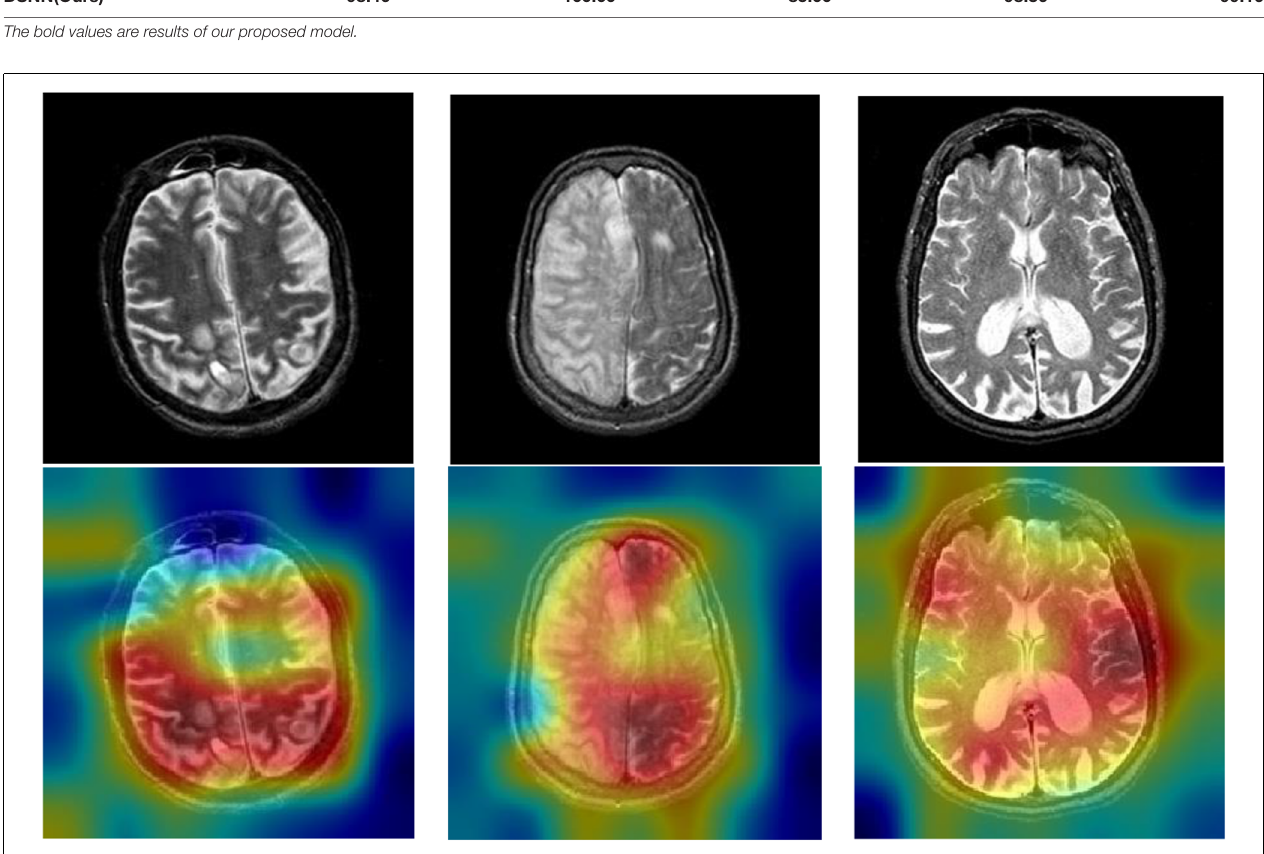
FIGURE 8 | Explainability of the proposed DSNN.